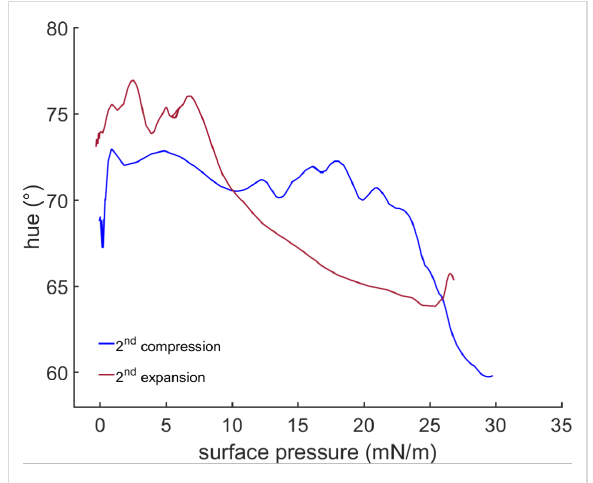
Figure 5: Correlation of the hue of a monolayer flipper probe with its measured surface pressure at the water/air interface at 20 °C subphase temperature and 22 °C air